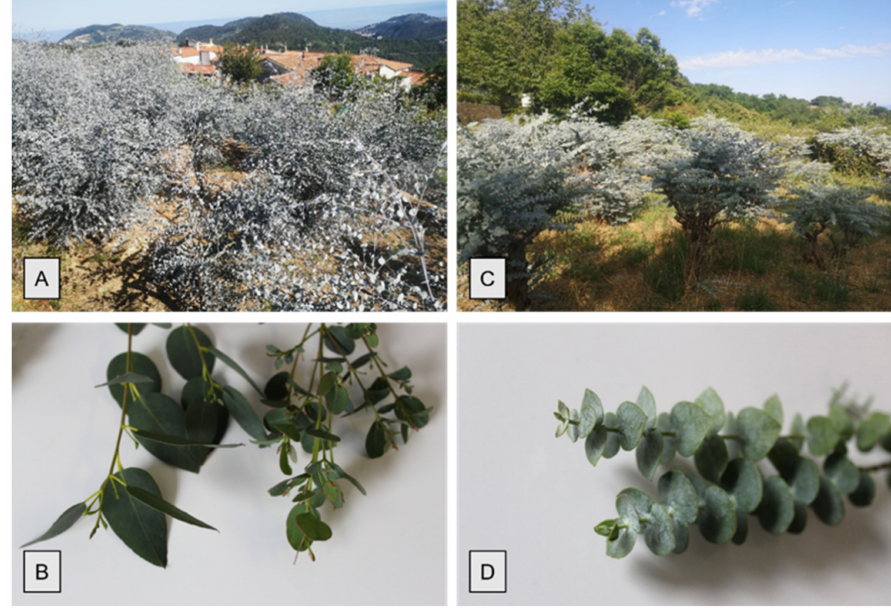
Figure 1. Plantation and branches of E. gunnii ( A , B ) and of E. pulverulenta ‘Baby blue’ ( C , D ).